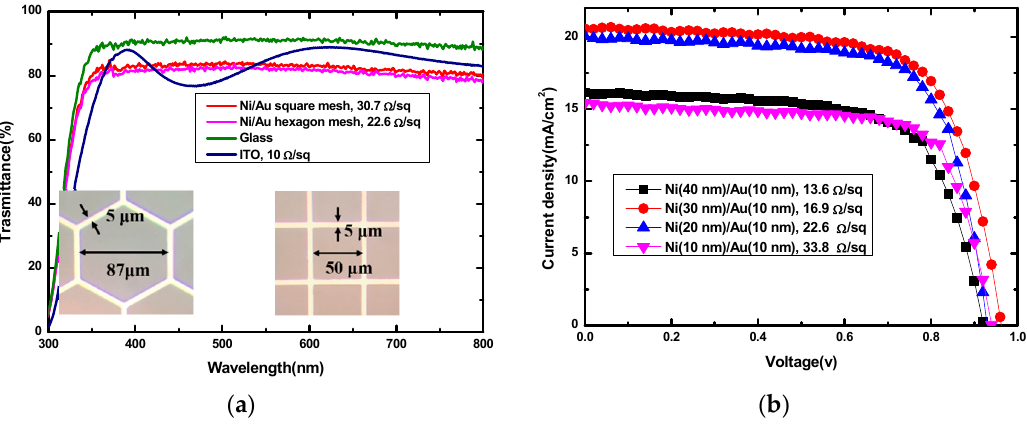
Figure 2. ( a ) Transmittance spectra of Ni (20 nm)/Au (10 nm) mesh (square, hexagon) and ITO on glass, and the glass substrate; ( b ) density ‐ voltage (J ‐ V) curves for PSCs with hexagon Ni(x nm)/Au (10 nm) (x = 10, 20, 30, 40 nm) metal mesh electrodes. The sheet resistances of Ni/Au and ITO electrode are also displayed in Figure 2.